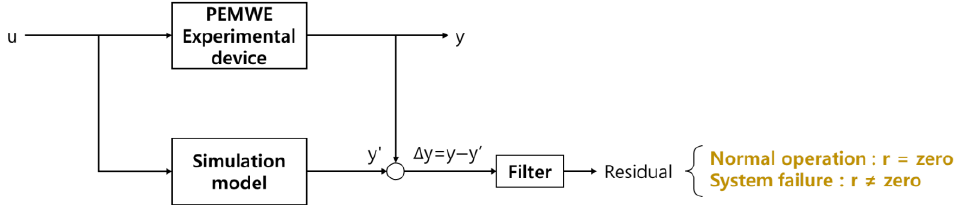
Figure 8. Fault-detection algorithm.